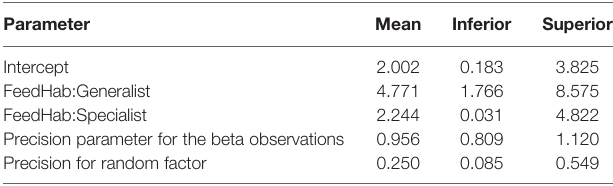
Tag deployment was included as a random